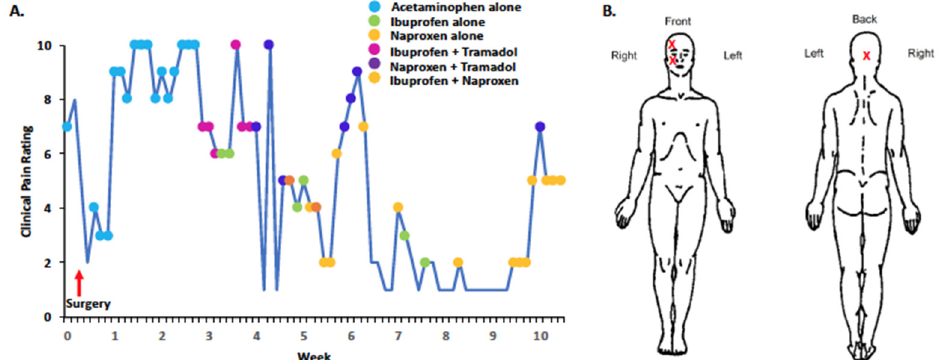
Figure 3. ( A ) The 10-week daily pain diary completed by Patient 2 at age 53. Average pain was assessed using a 0–10 numerical rating scale and was initiated before surgical treatment to lessen craniofacial FD lesions. ( B ) At baseline and using the BPI, anatomical regions where pain was experienced were confined to craniofacial areas.